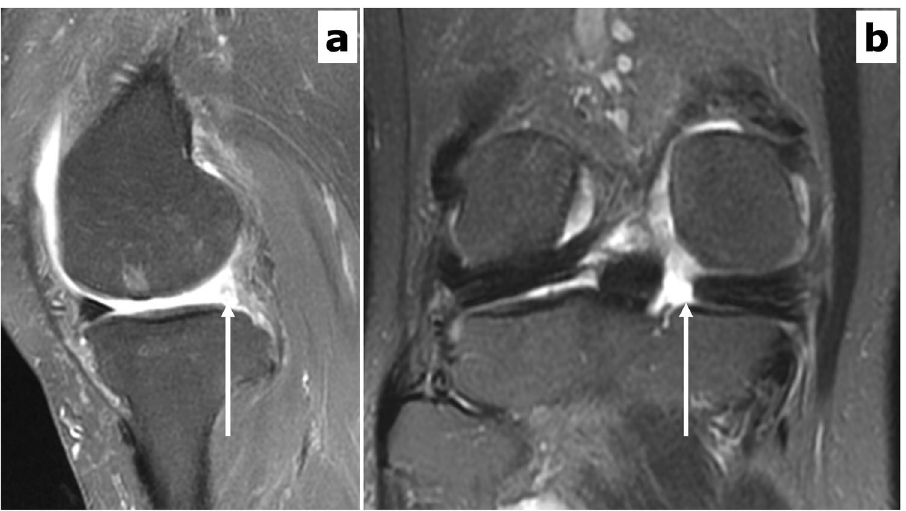
Figure 2. Ghost meniscus sign on a fat-suppressed T2-weighted sagittal image. ( a ) Sagittal view showing ghost meniscus sign, ( b ) coronal view showing a defect of the medial meniscus posterior root. An abnormally high signal, indicating the absence of an identifiable meniscal body, is detected in place of the normal dark meniscal signal at the posterior horn of the medial meniscus